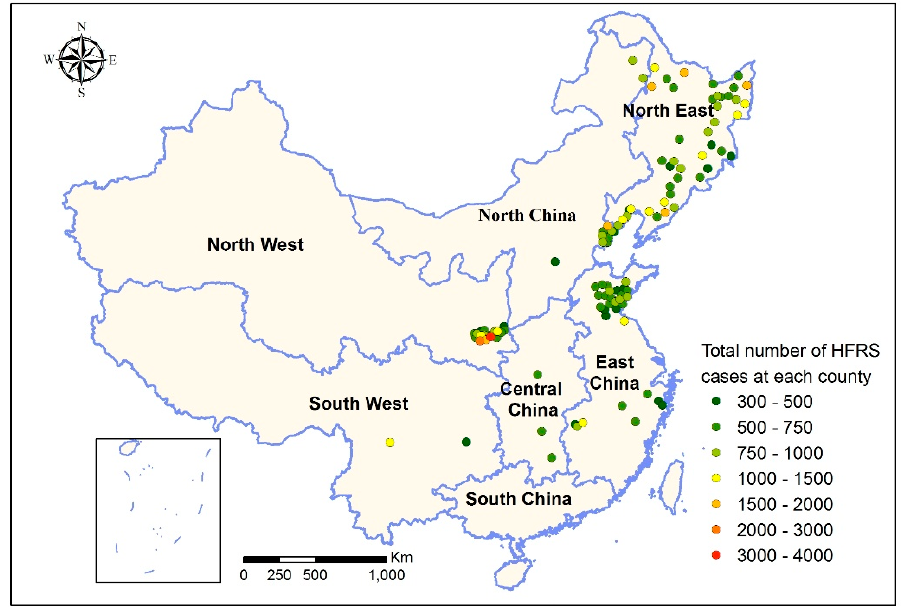
Figure 1. Total number of hemorrhagic fever with renal syndrome (HFRS) cases for the study period 2002–2013 in 109 counties of China.